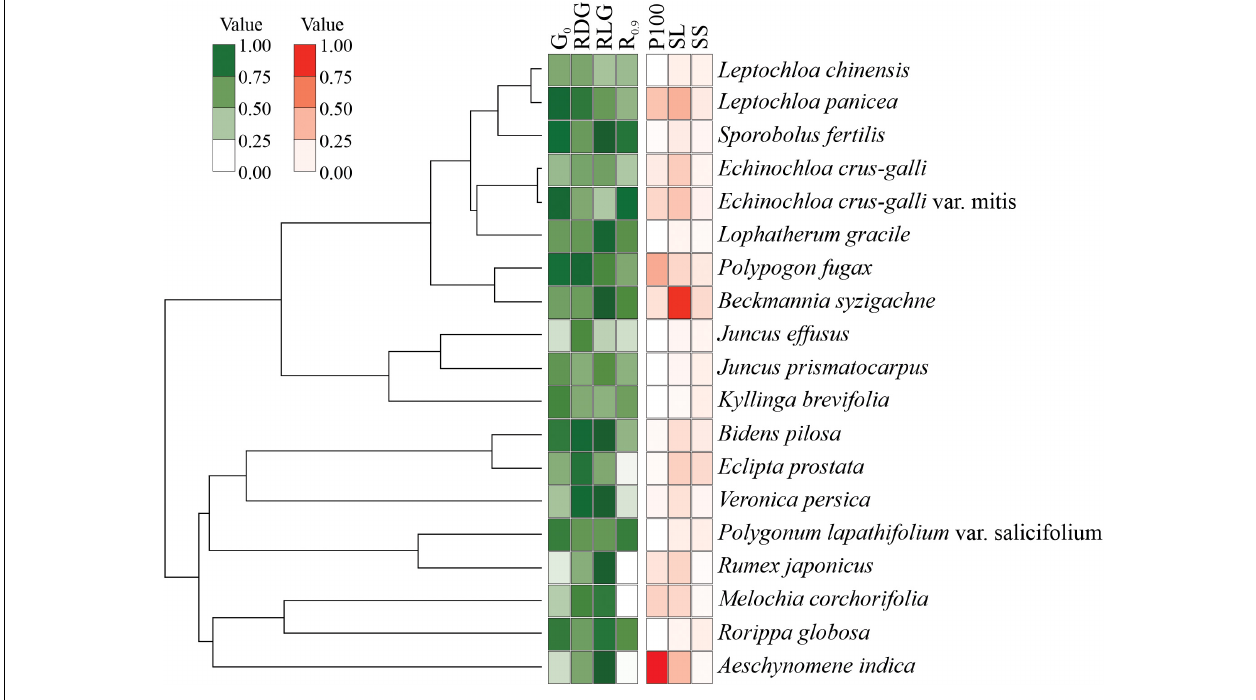
FIGURE 5 | Cluster analysis of species using seed germination